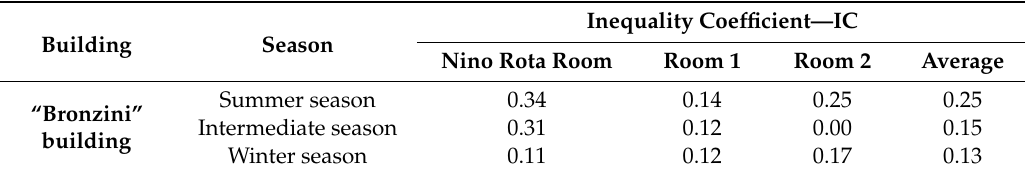
Table 8. Inequality Coefficient for the “Bronzini” building.